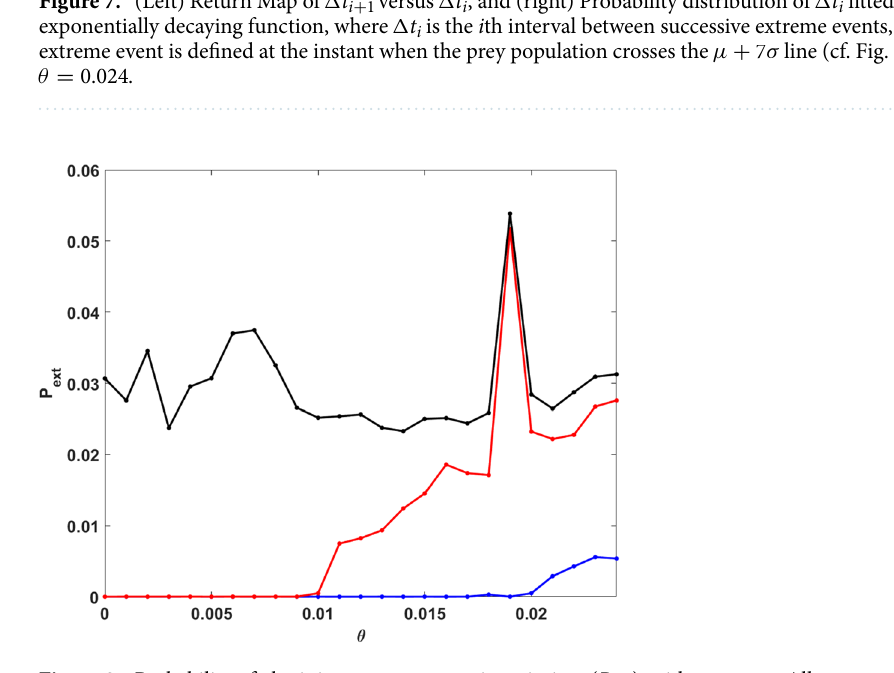
Figure 8. Probability of obtaining extreme event in unit time ( P ext ), with respect to Allee parameter θ , estimated by sampling a time series of length T = 5000 , and averaging over 500 random initial states. Here we consider that an extreme event occurs when a population level crosses the threshold µ + 7 σ . P ext for vegetation, prey and predator are displayed in blue, red and black colors respectively. Note that there exists a narrow periodic window around θ ∼ 0.02 (cf. Fig. 9), and so the large deviations in this window of Allee parameter are not associated with true extreme events, as they occur